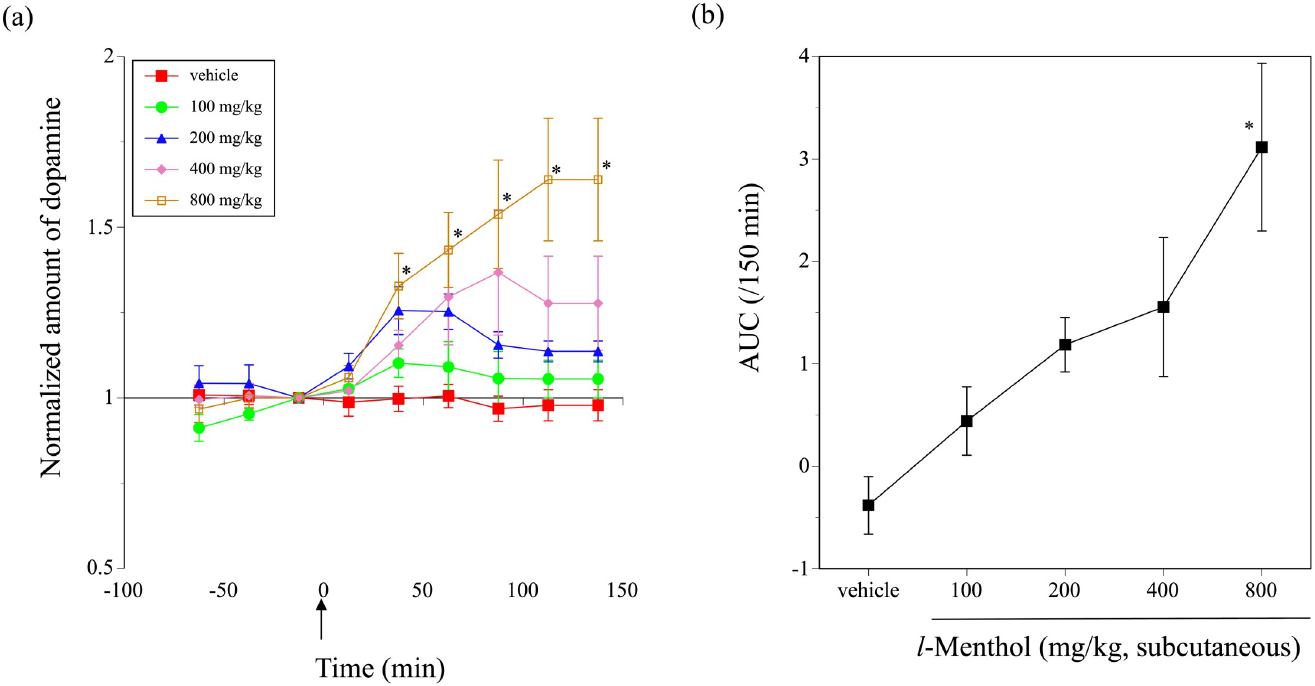
Fig 5. Effects of the subcutaneous administration of 100 to 800 mg/kg l -menthol on the extracellular dopamine level in the dorsal striatum of free-moving mice. (a) Changes in the dopamine level in the dialysates obtained from the dorsal striatum of mice administered saline or 100 to 800 mg/kg l -menthol. The data are presented in S3 Data. (b) The dose-response relationship for the effect of l -menthol on the dopamine level as evaluated using the AUC. � P < 0.05 compared with saline by Tukey’s test. N = 10 to 16.